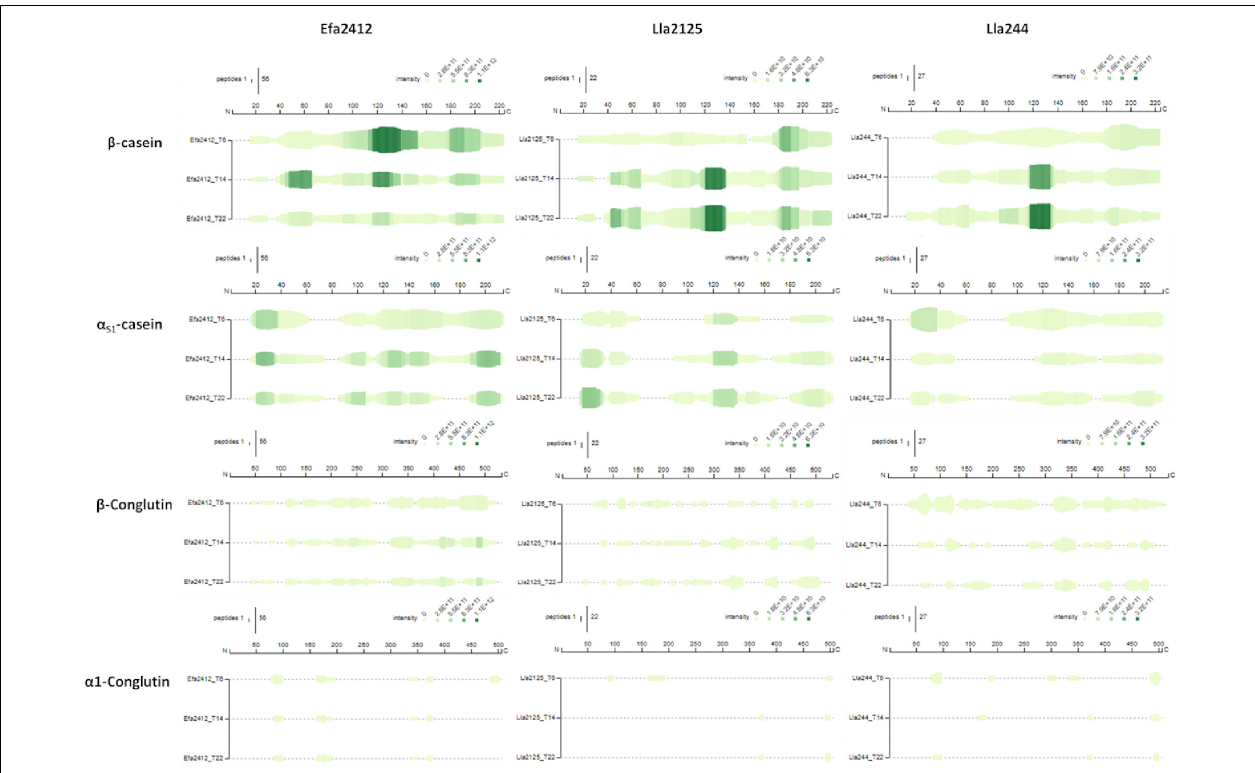
FIGURE 6 | Peptide profiles on the β -casein (CASB), α S1 -casein (CASA1), α 1 -conglutin (CONA1), and β -conglutin (CONB2). The color scale represents the summed abundances and is normalized for the four proteins for each donor strain (Note that it differs for a given protein, between the three strains). The size of the vertical bars represents the number of peptides considered for each amino acid in the sequence. The peptides were aligned on the protein sequences provided by the database Uniprot (uniprot.org) using the online software Peptigram (http://bioware.ucd.ie/peptigram/). The identifiers are: F5B8V6 for CONA1, Q6EBC1 for CONB2, P02662 for CASA1, and P02666 for CASB. The signal sequence is included.